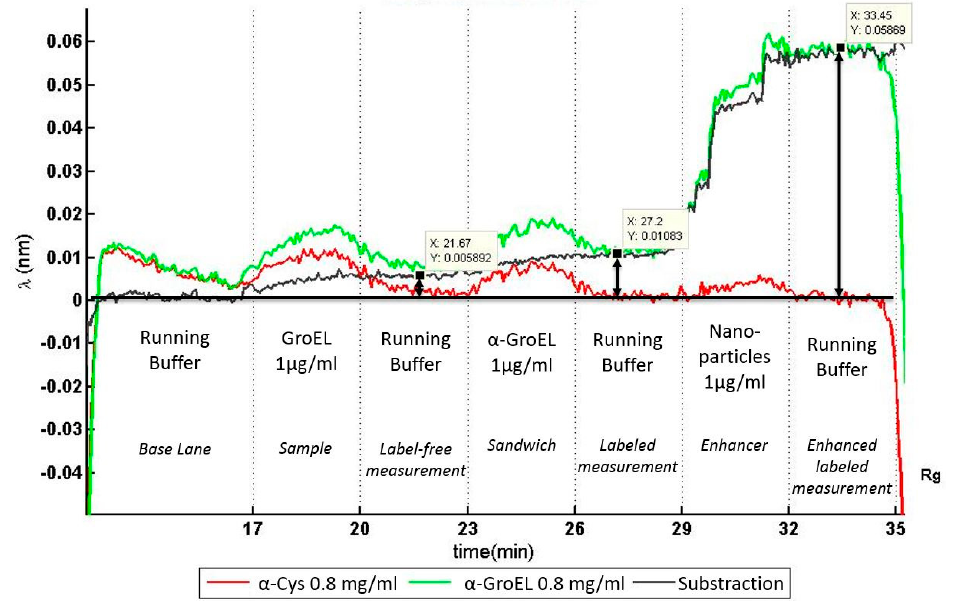
Figure 7. Optofluidic immunoassay. Results of an immunoassay experiment automatically performed by the microfluidic cartridge and monitored by the photonic sensor. With a differential frequency shift of 60 pm, only the labeled measurement, which was enhanced with functionalized nanoparticles, showed a significant signal increase.